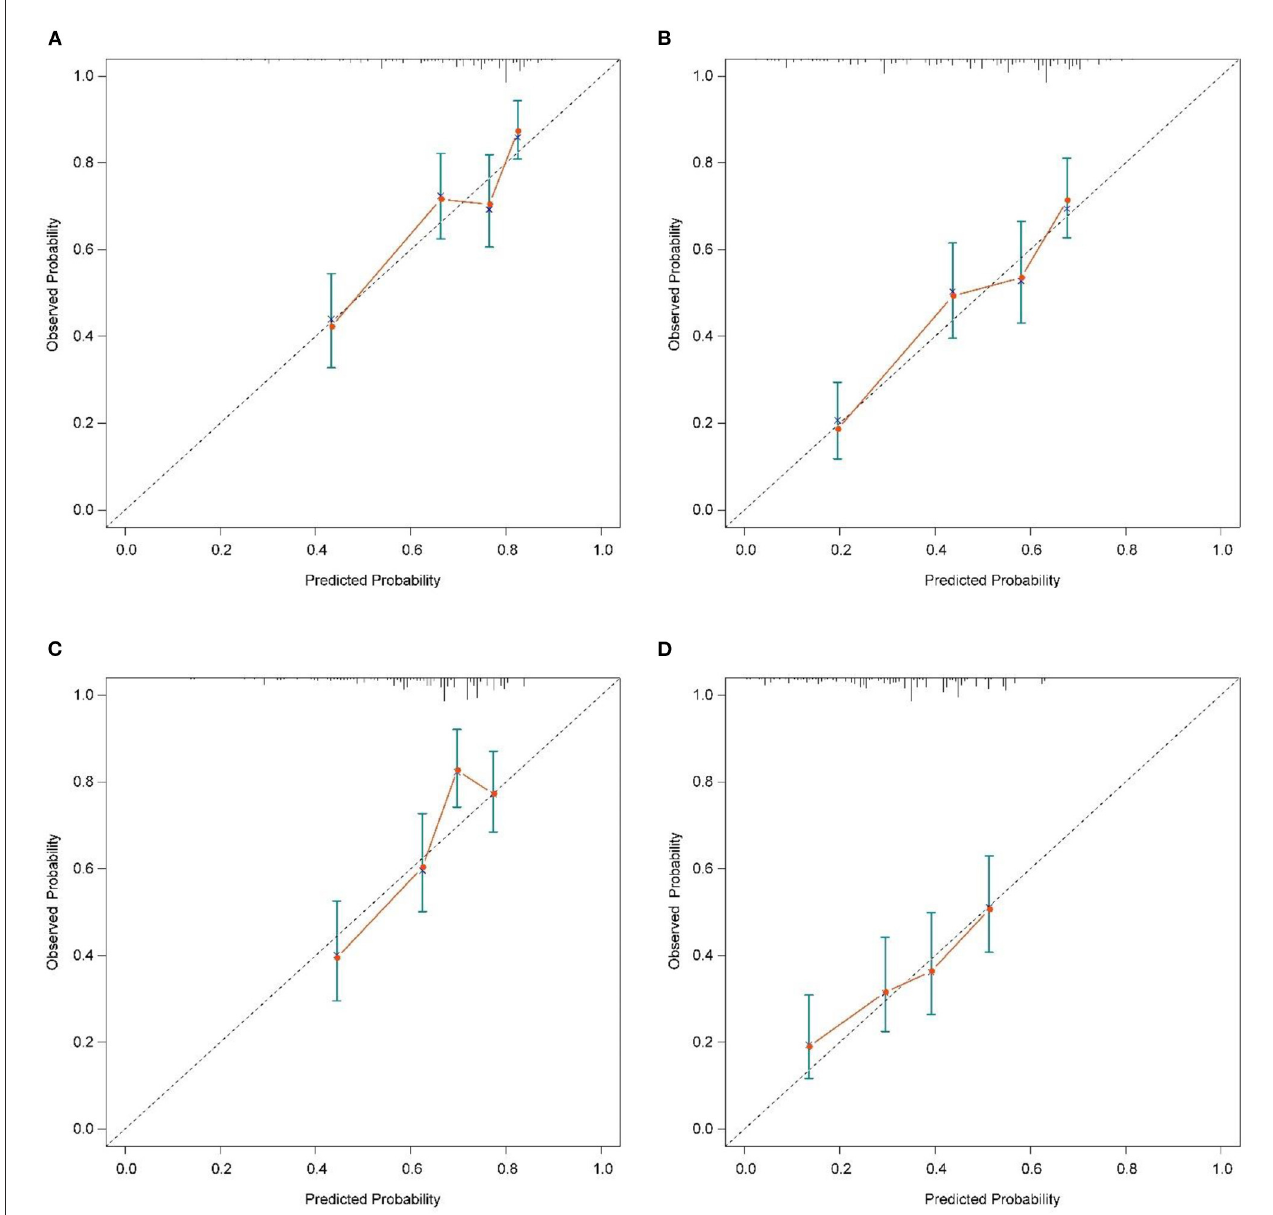
FIGURE4 Calibration plots of the nomogram for 6-, and 12-month CSS prediction of the training set (A, B) and verification set (C, D) . X-axis represents the nomogram-predicted probability of survival; Y-axis represents the actual CSS probability. A perfectly accurate nomogram prediction model would result in a plot that the observed and predicted probabilities for given groups fall along the 45-degree line. Dots with bars represent nomogram-predicted probabilities along with 95% confidence interval. CSS, cancer-specific